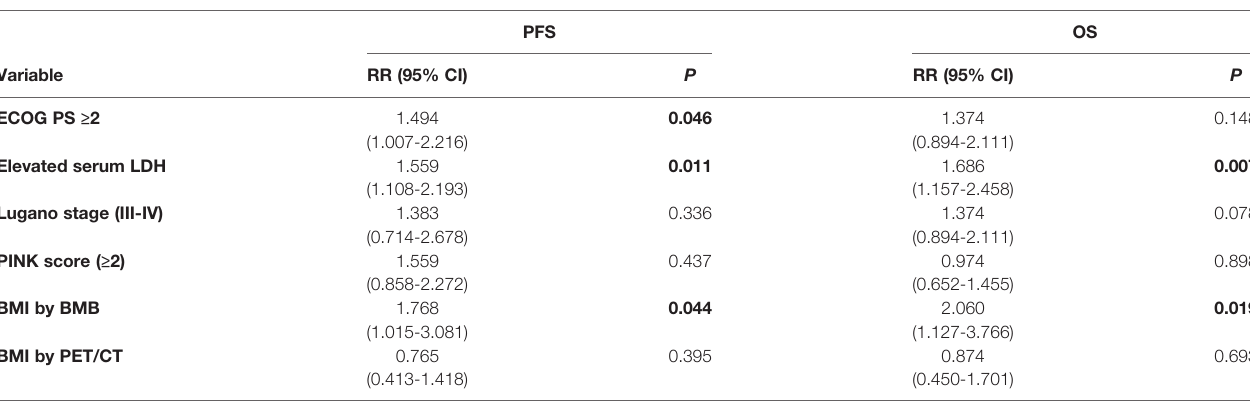
TABLE 5 | Multivariate analysis of PFS and OS in 356 patients with